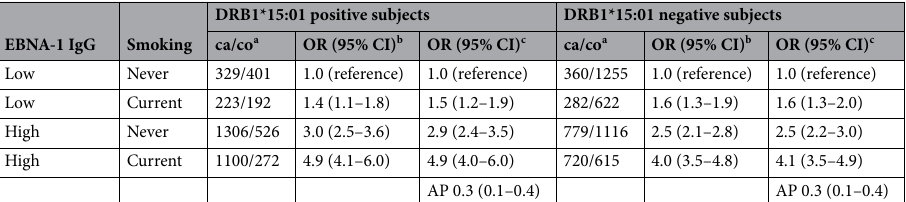
All main findings remained significant when the studies were analyzed separately (data not shown). Our results remained almost identical after carrying out the analyses on the multiple imputed data 25 (data not shown). Our results also remained stable when smoking was considered 2 years prior to the index year (data not shown).